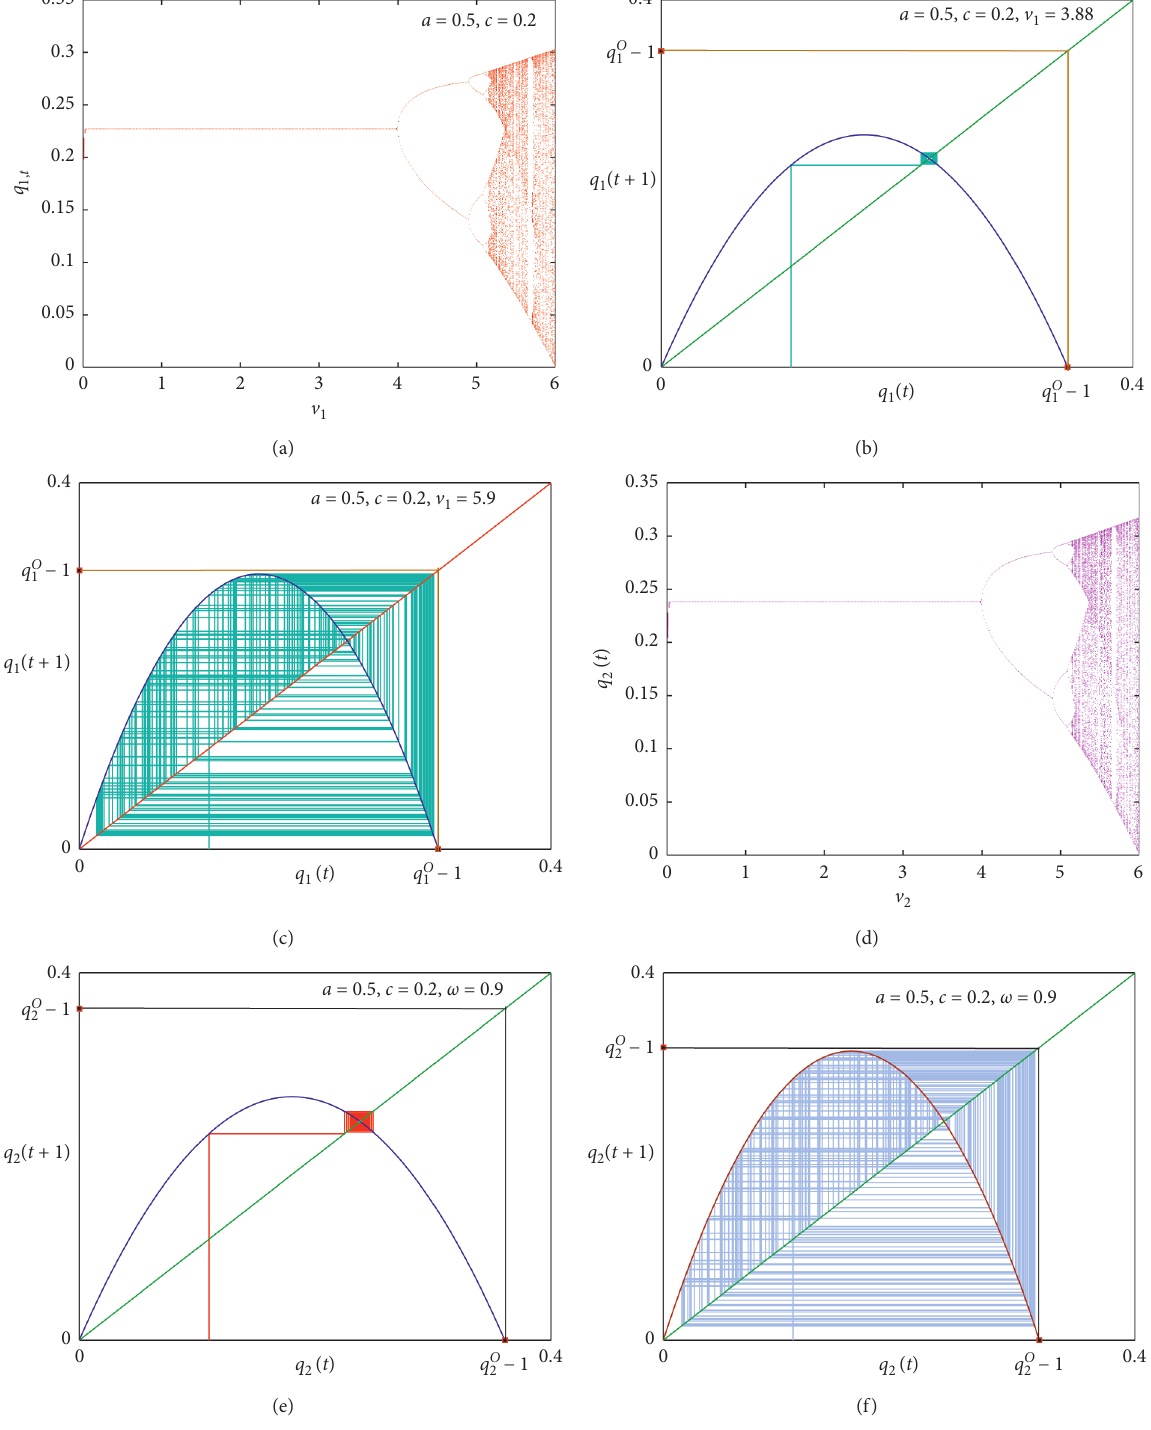
Figure 1: (a) Bifurcation diagram in ( ] attraction of the stable point q O 1 k � 3 . 88. (f) The basins of attraction of the stable point q O 2